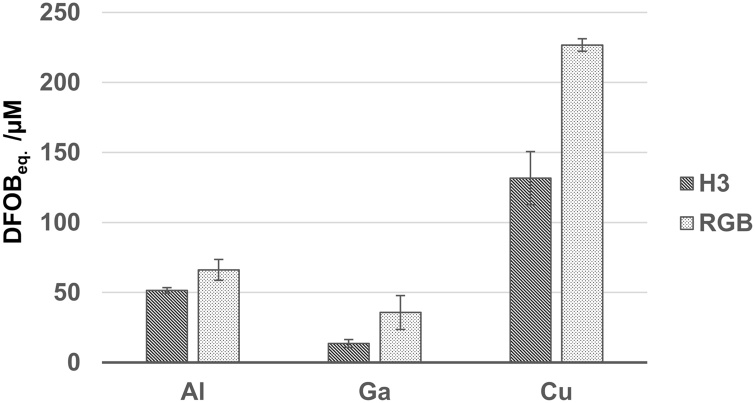
Binding of the metal ions Al3+, Ga3+ and Cu2+ by culture supernatants of Pseudomonas sp. H3 and RGB. DFOBeq. - desferrioxamine B equivalents.